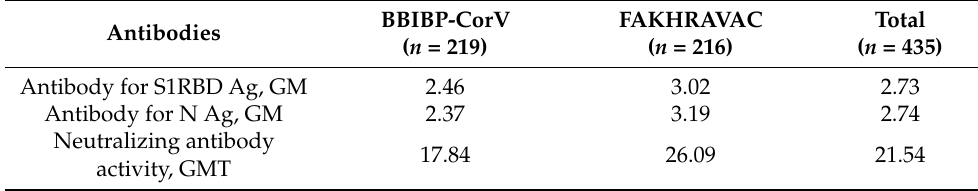
Table 2. Baseline geometric mean of the level of specific antibodies.